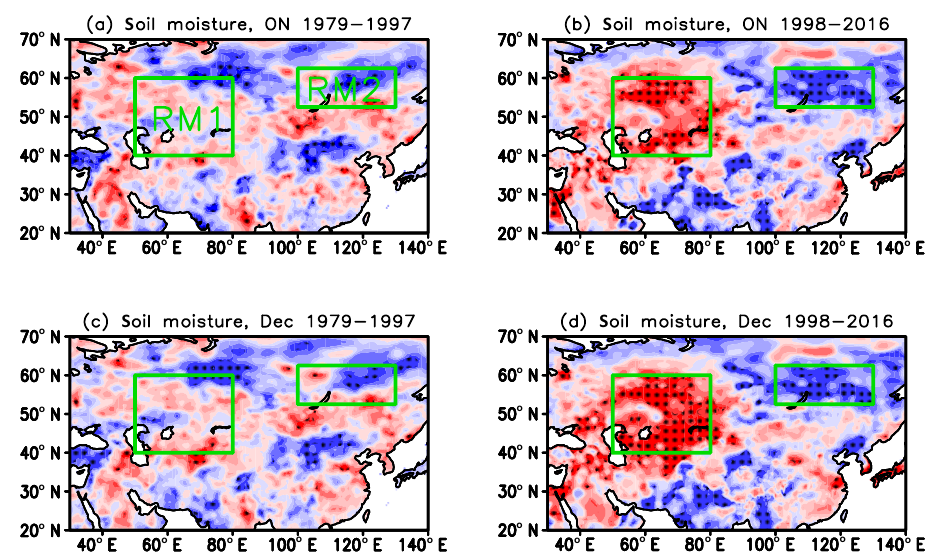
Figure 9. The CC between the SC ES and soil moisture in (a) October–November (ON) and (c) December (Dec.) from 1979 to 1997, and in (b) October–November and (d) December from 1998 to 2016. The black dots indicate the CC exceeded the 95% confidence level ( t test). The linear trend is removed. The green boxes (RM1 and RM2) are the significantly correlated areas, which were used to calculate the SoilM